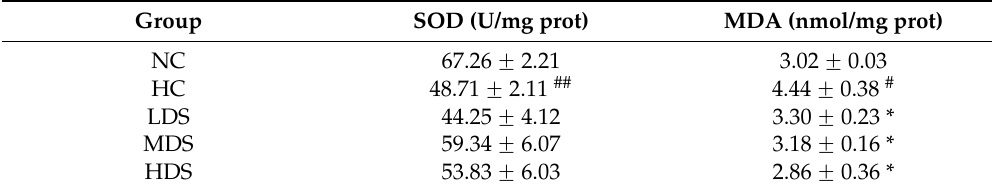
Table 4. Oxidative stress parameter levels in the renal tissue of rats after sesamin treatment.